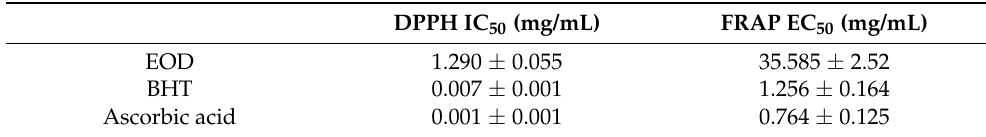
Table 2. IC 50 (mg/mL) of the essential oil, BHT, and ascorbic acid by DPPH and FRAP assays. Results are expressed as mean ± SD.